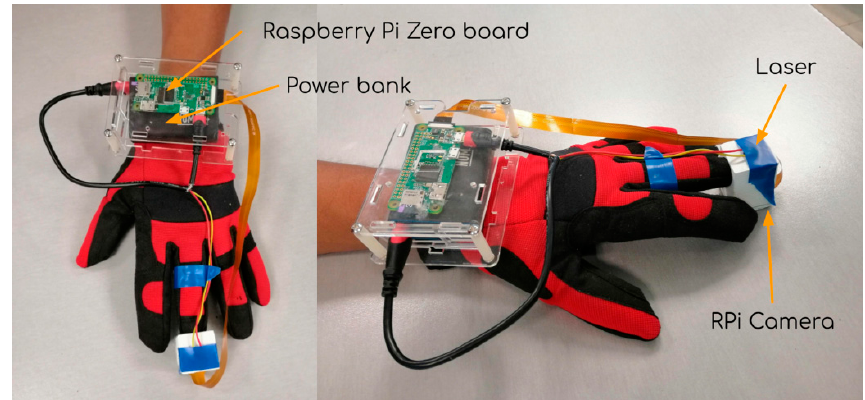
Figure 4. Final IoT sensor setup instrumentation.